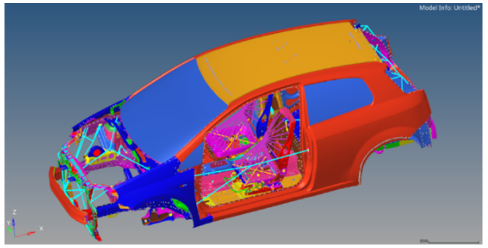
Figure 2. Trimmed Body